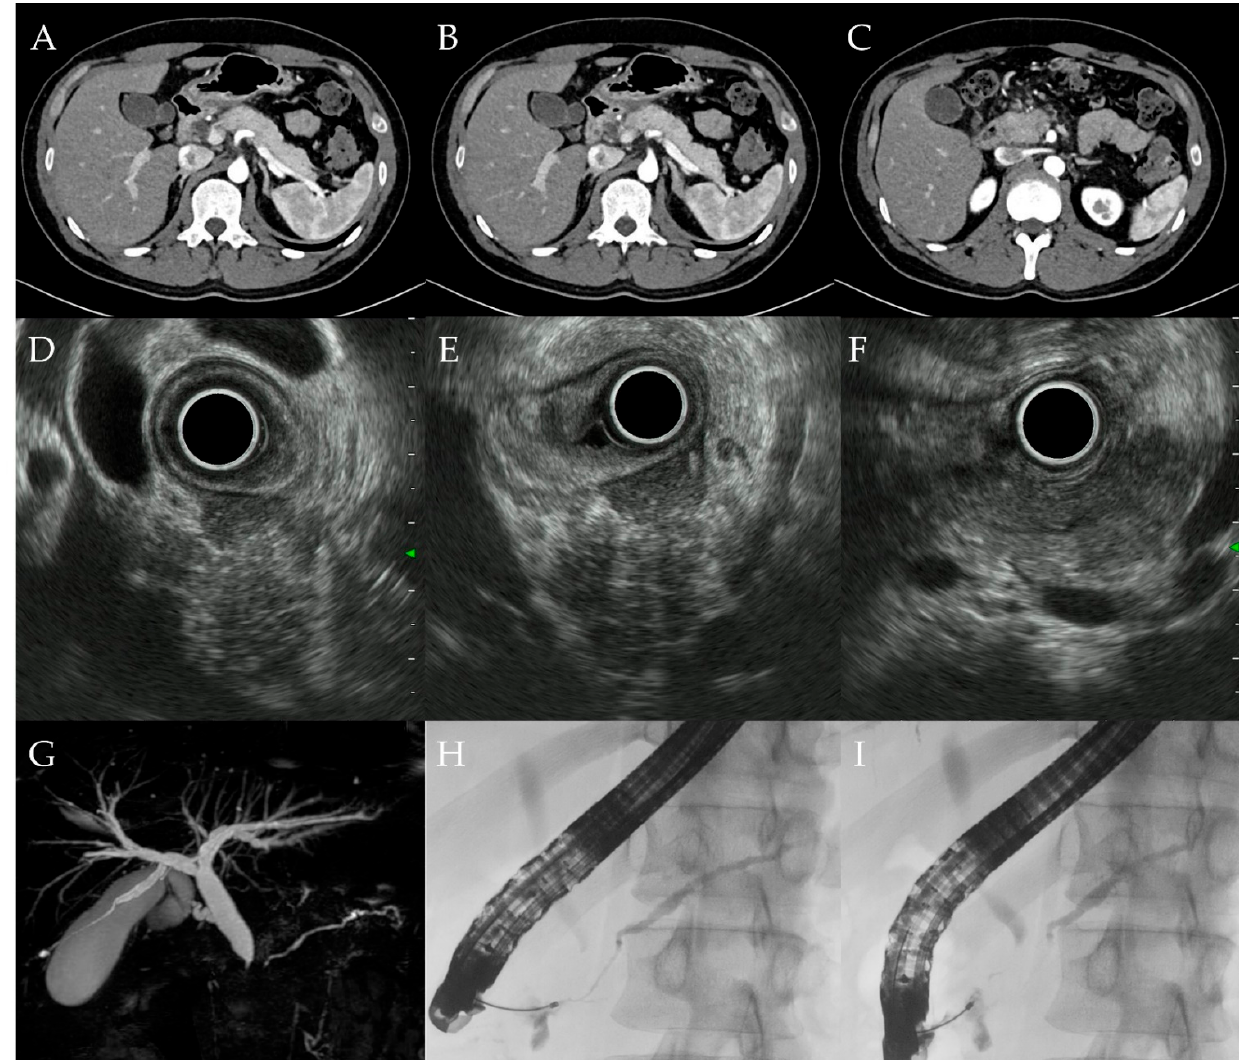
Figure 3. Image findings of case 10. ( A – C ) Computed tomography (CT) showing diffuse pancreatic enlargement. ( D – F ) Endoscopic ultrasound showing diffuse pancreatic enlargement and a mass in the pancreatic head. ( G ) Magnetic resonance imaging showing intrapancreatic bile duct stenosis and MPD narrowing. ( H , I ) Endoscopic retrograde cholangiopancreatography (ERCP) showing MPD narrowing and intrapancreatic bile duct stenosis.